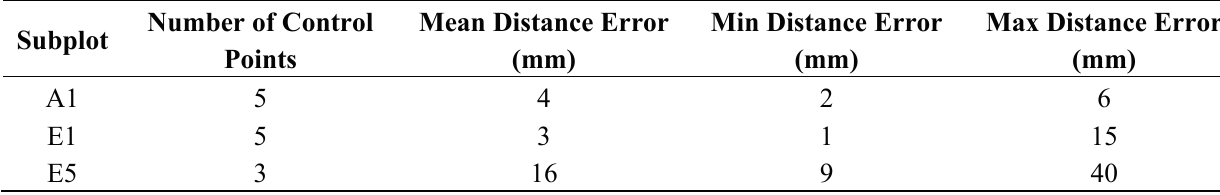
Table 2. Co-registration errors using sphere centroid coordinates.